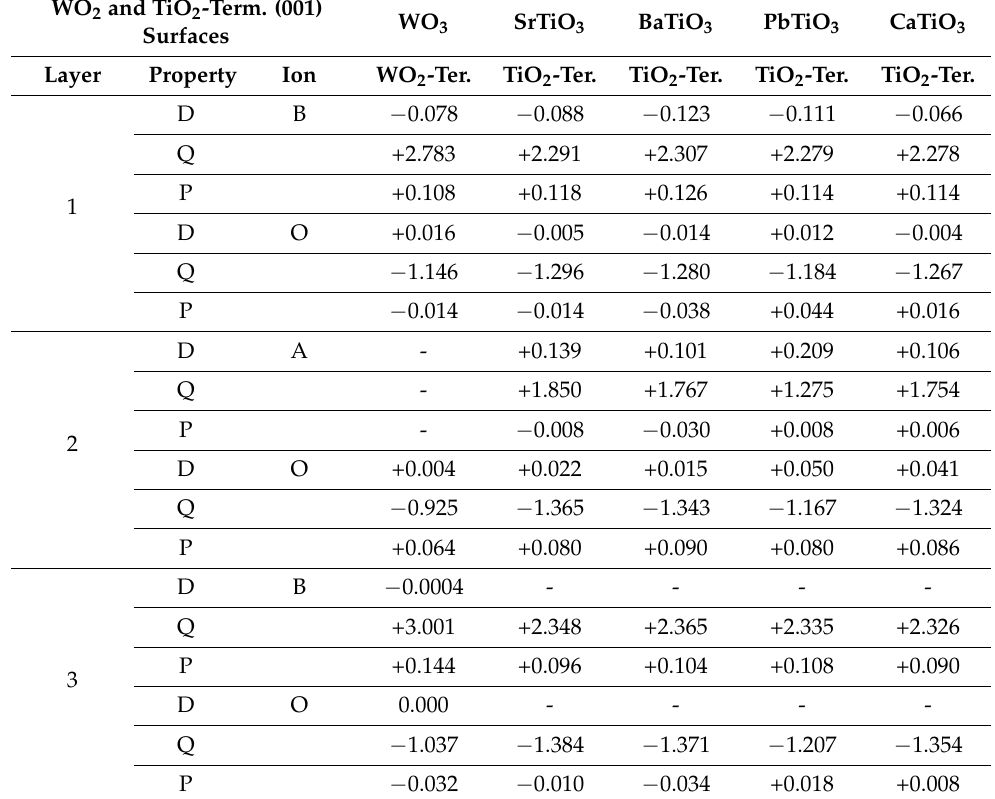
Table 7. Our B3LYP- or B3PW-calculated atomic shift magnitudes D (in Å ) as well as the effective atomic charges Q (in e ) and nearest atomic chemical bond populations P (in e ) for the WO 2 - and TiO 2 -terminated WO 3 , SrTiO 3 , BaTiO 3 , PbTiO 3 and CaTiO 3 (001) surfaces. WO 2 and TiO 2 -Term. (001)